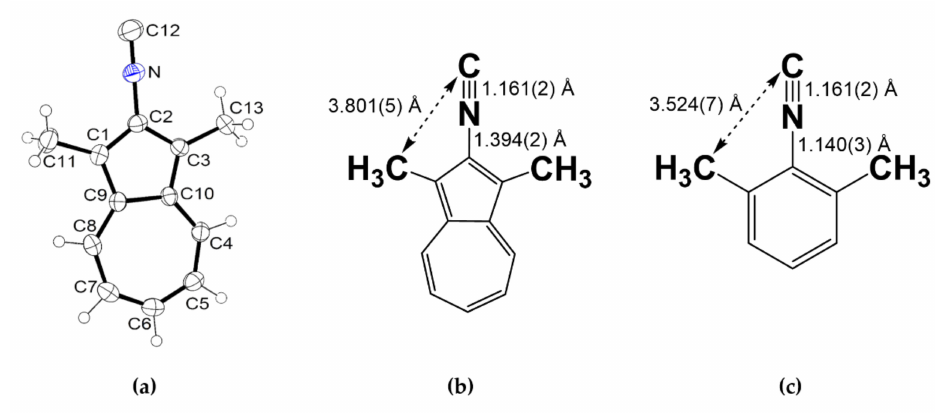
Figure 3. ( a ) Solid-state structure of 2 , 50% thermal ellipsoids; ( b ) C ≡ N, N–C bond lengths, and average C(methyl) ··· C(isocyano) distance in the solid-state structure of 2 ; ( c ) C ≡ N, N–C bond lengths, and C(methyl) ··· C(isocyano) distance in the solid-state structure of 2,6-xylyl isocyanide (average parameters for two crystallographically independent molecules